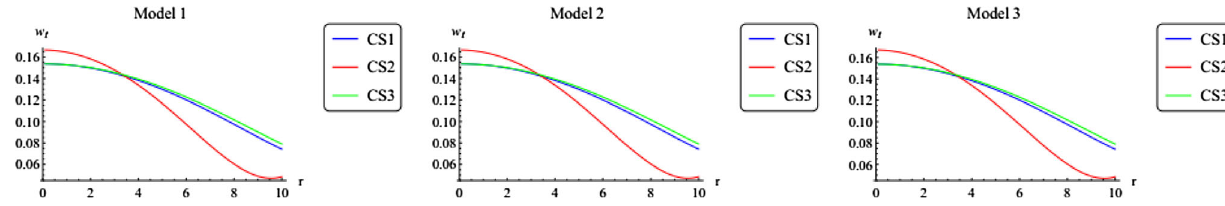
Fig. 14 Variations of the transverse EoS parameter for different viable f ( G ) gravity models